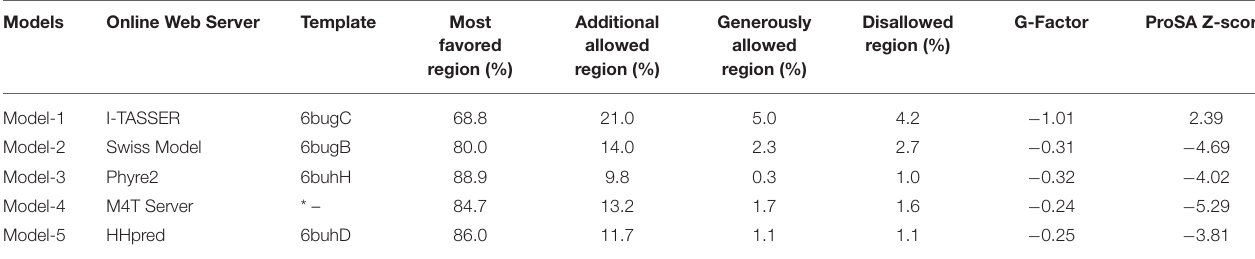
TABLE 1 | Quality assessment of MBOAT7 models.